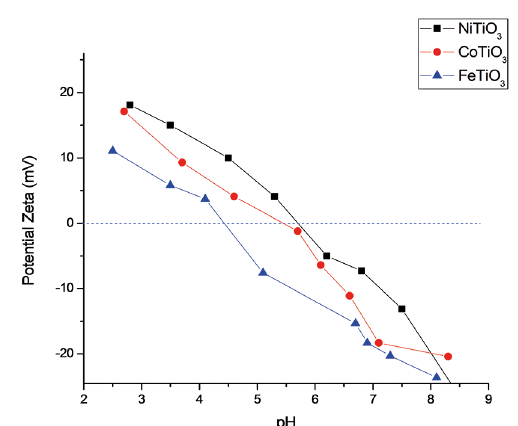
Figure 7. Zeta potentials of the titanates synthetized by the solvo- combuation method measured as a function of pH.